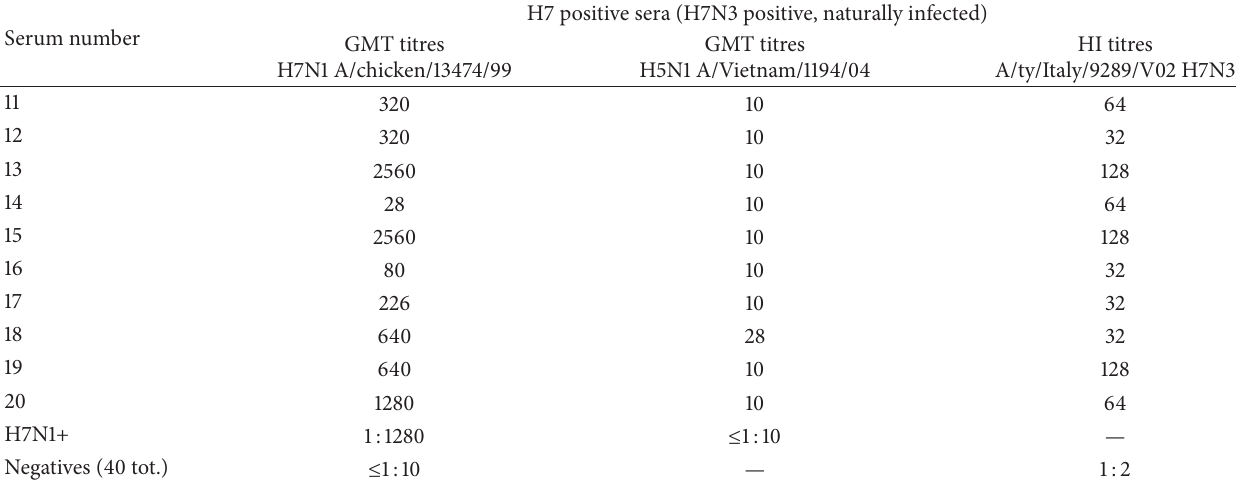
Table 2: Comparison of neutralizing activity of panel of sera collected from naturally infected turkeys with H7N3 A/turkey/Italy/2002.